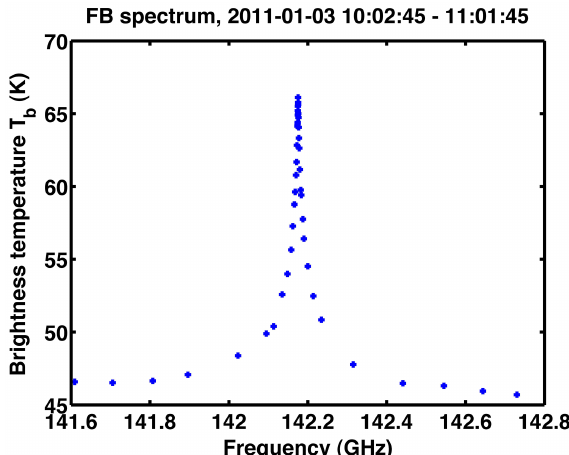
Figure 1. Measurement of the ozone spectrum line at 142GHz at Bern on a winter day with the filter bench spectrometer. The inte- gration time is 60min.